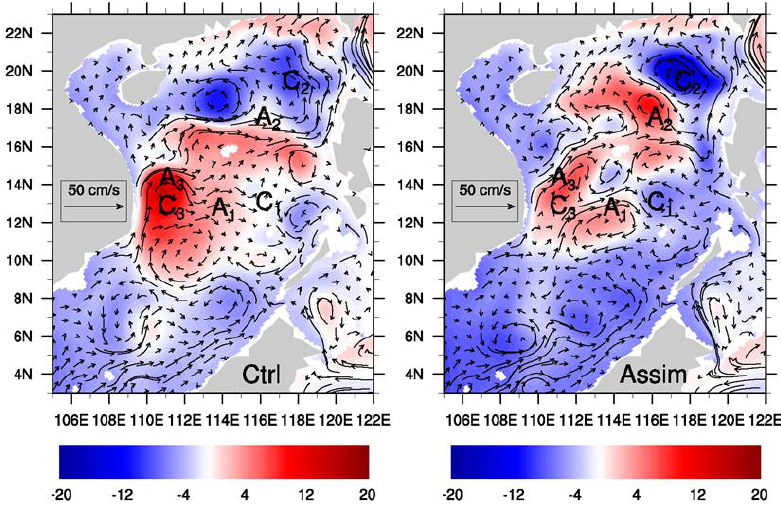
Fig. 11. Comparison of the monthly surface currents (black arrows) and SLA (shaded colors) in May 1995 for the control run (Ctrl, left) and the assimilation run of (Assim, right). The marker A 1 , A 2 , A 3 , and C 1 , C 2 , C 3 denote the positions of anticyclonic and cyclonic eddies according to Chu et al. (1998).